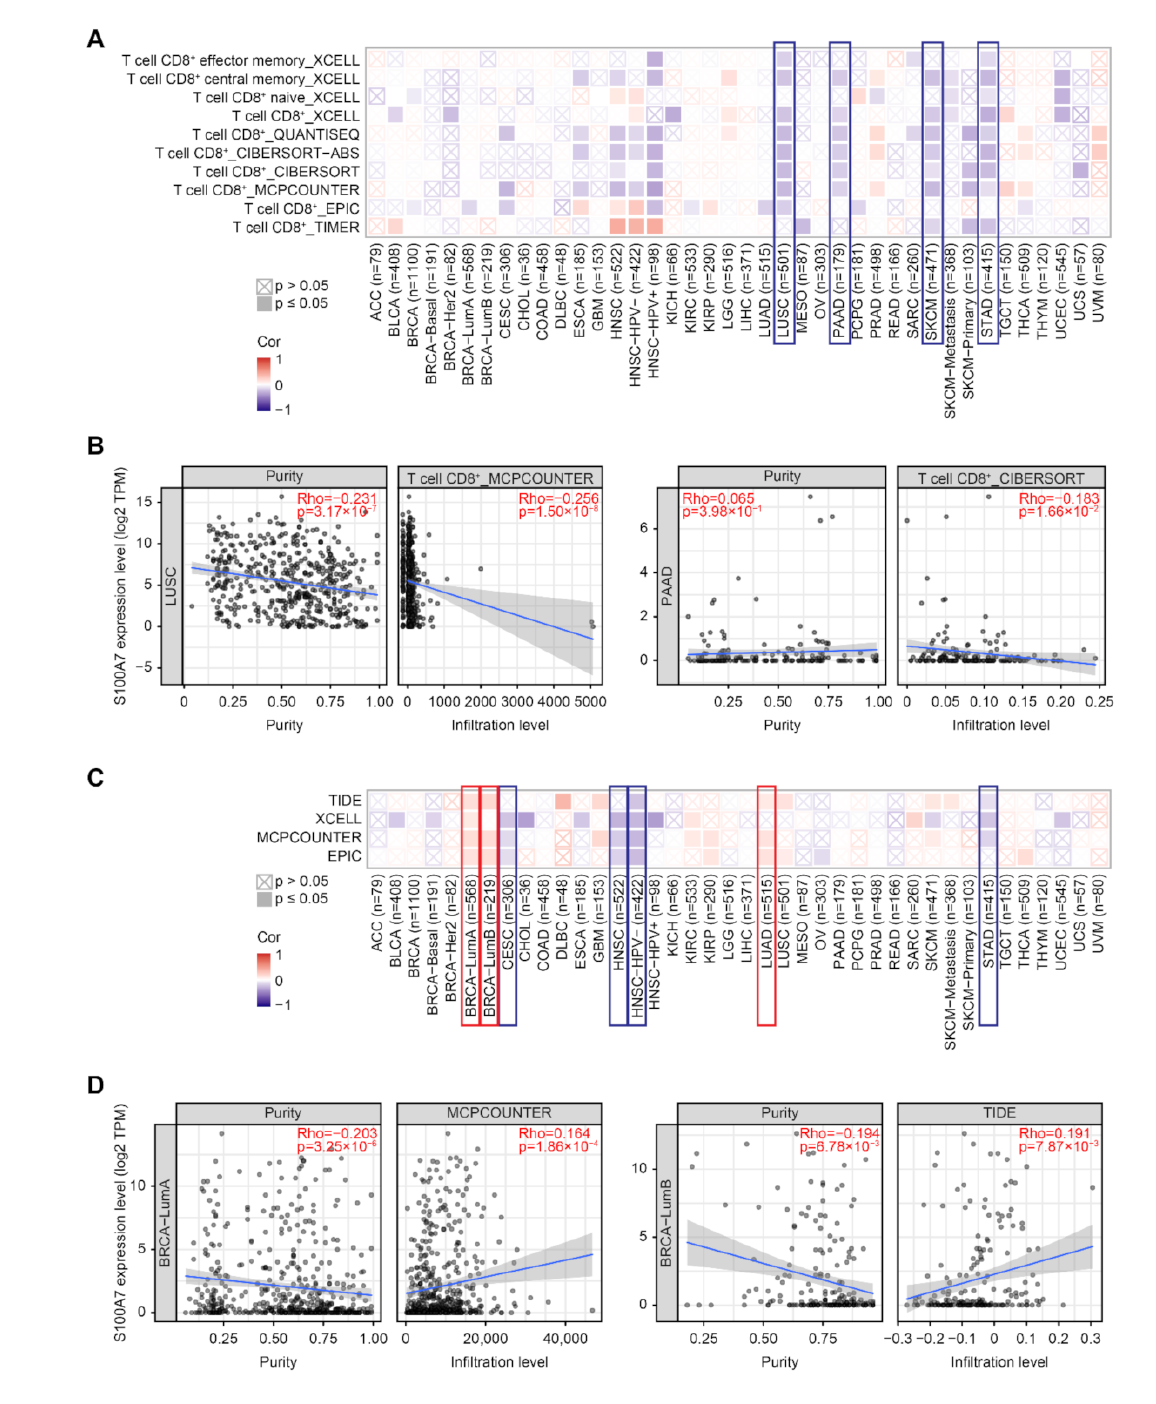
Figure 5. Correlation analysis between S100A7 expression and immune infiltration of cancer- associated fibroblasts. ( A ) The correlation between the gene expression level of S100A7 and the infiltration level of CD8 + T-cells with different algorithms. ( B ) The relationship between S100A7 and the infiltration level of CD8 + T-cells across LUSC and PAAD. ( C ) The correlation between the gene expression level of S100A7 and the infiltration level of cancer-associated fibroblasts with different algorithms. ( D ) The relationship between S100A7 and the infiltration level of cancer-associated fibroblasts across BRCA-LumA and